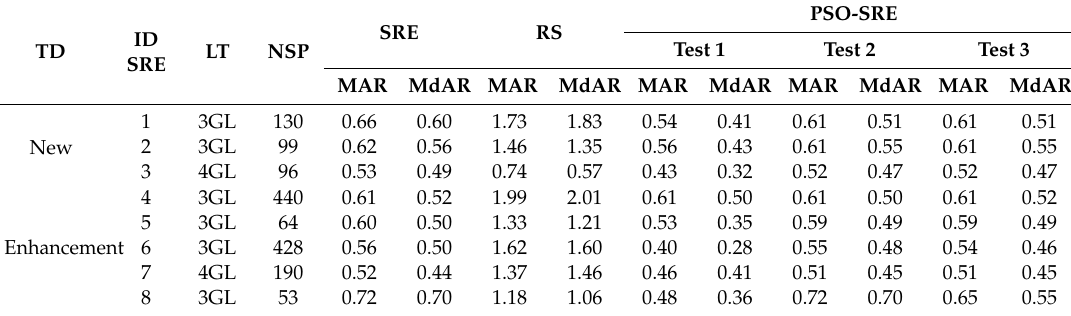
Table 9. Prediction accuracies by